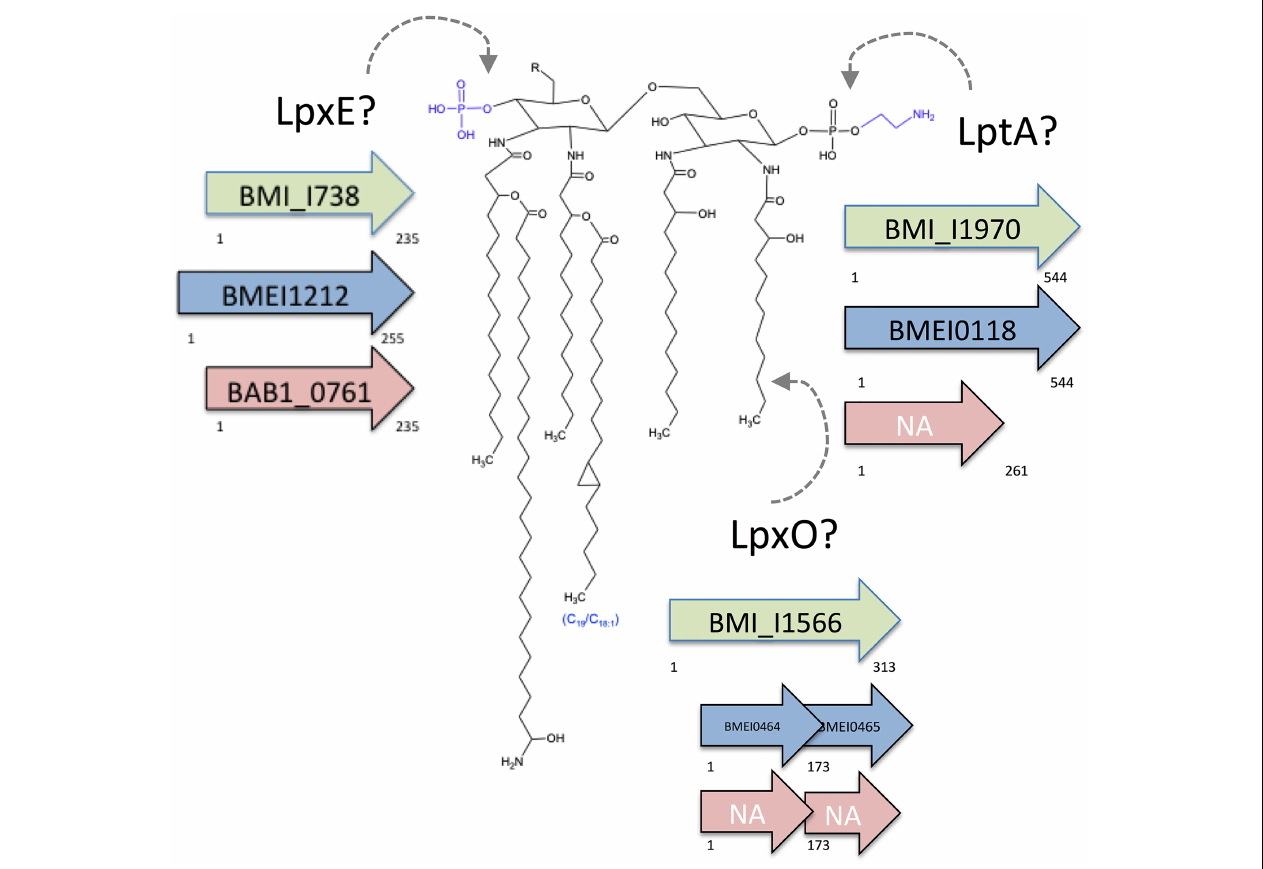
FIGURE 1 | Brucella lipid A and hypothetical sites of action of putative LpxE, LptA, and LpxO. The structure proposed is based on acyl-chain and mass spectrophotometry analyses and genomic predictions. The predicted sites of action of LpxE (phosphatase), LptA (pEtN transferase), and LpxO (acyl chain hydroxylase) are indicated, and the corresponding ORF of B. microti (green) , B. melitensis (blue), and B. abortus (red) presented (NA, not annotated). The B. abortus lptA homolog and the B. melitensis and B. abortus lpxO homologs carry a frame-shift